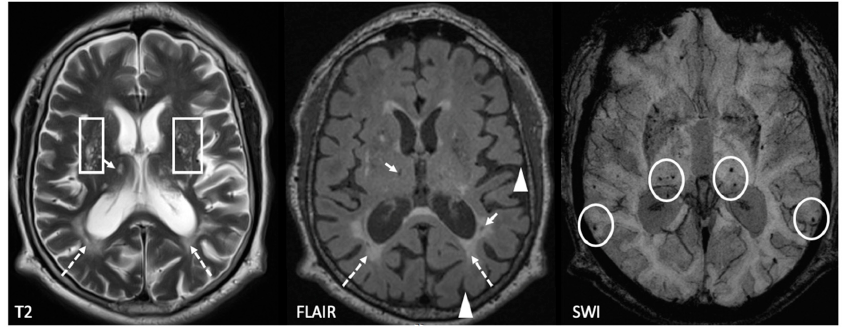
Figure 1. Example of characteristic SVD MRI features: dotted arrows—white matter hyperintensities (WMH), solid arrows—lacunes, circles—microbleeds, triangles—sulcus enlargement as a marker of brain atrophy, and rectangles—multiple enlarged perivascular